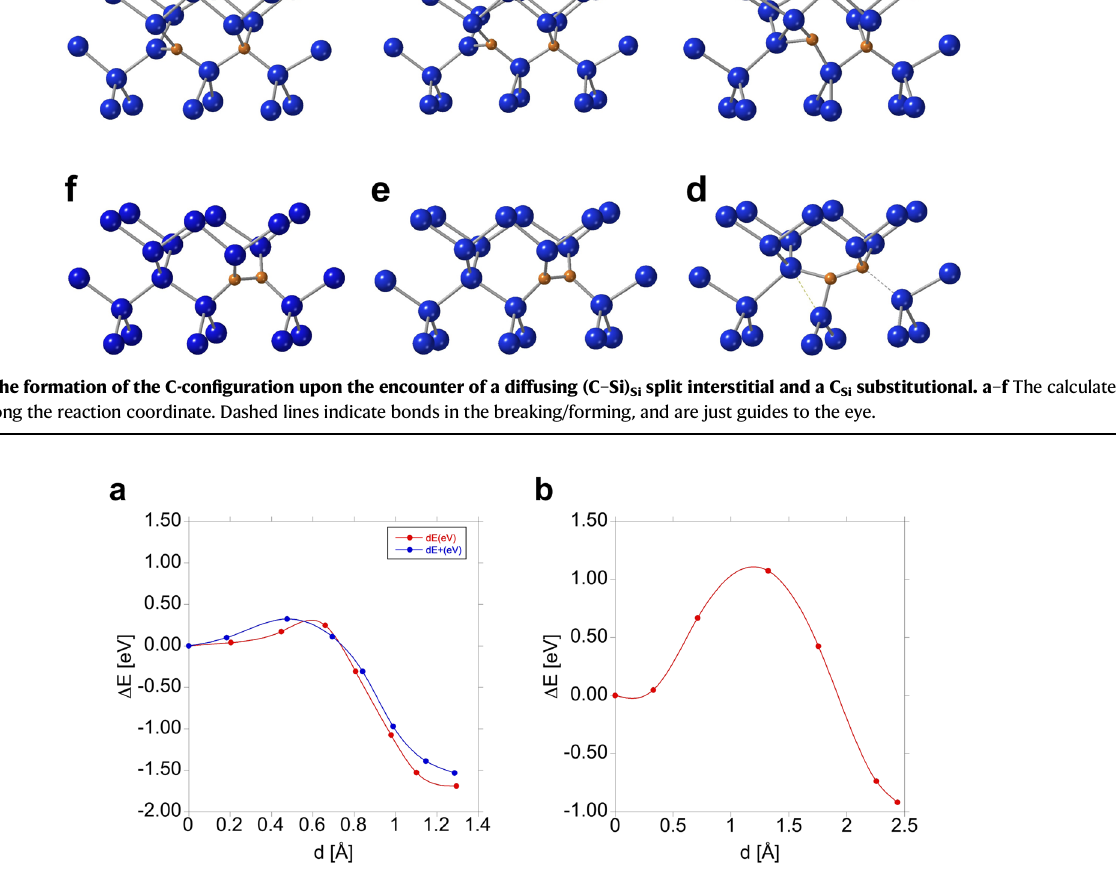
guide the eye. a The formation of the neutral (red curve) and positive (blue curve) A - con fi guration. b The formation of the neutral C - con fi